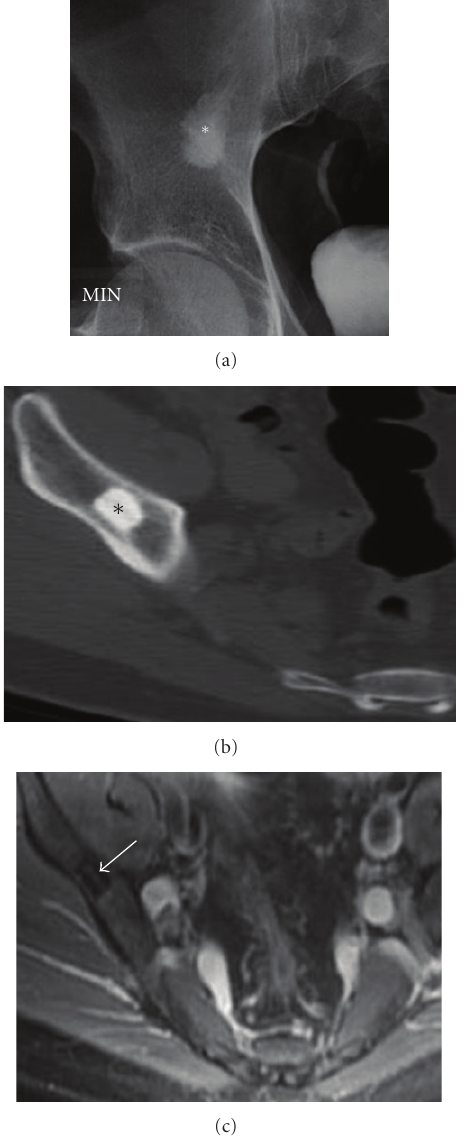
Figure 16: Bone island. Incidental right ilium lesion noted in a 47-year-old patient presenting with hematuria diagnosed as a bone island. AP radiograph (a) depicts a large sclerotic lesion with speculated margins blending with surrounding trabecula, a characteristic finding of a bone island (enostosis). A bone island is cortical bone in the medullary cavity (b) and hence is of low signal in all MR sequences including axial T2 MRI